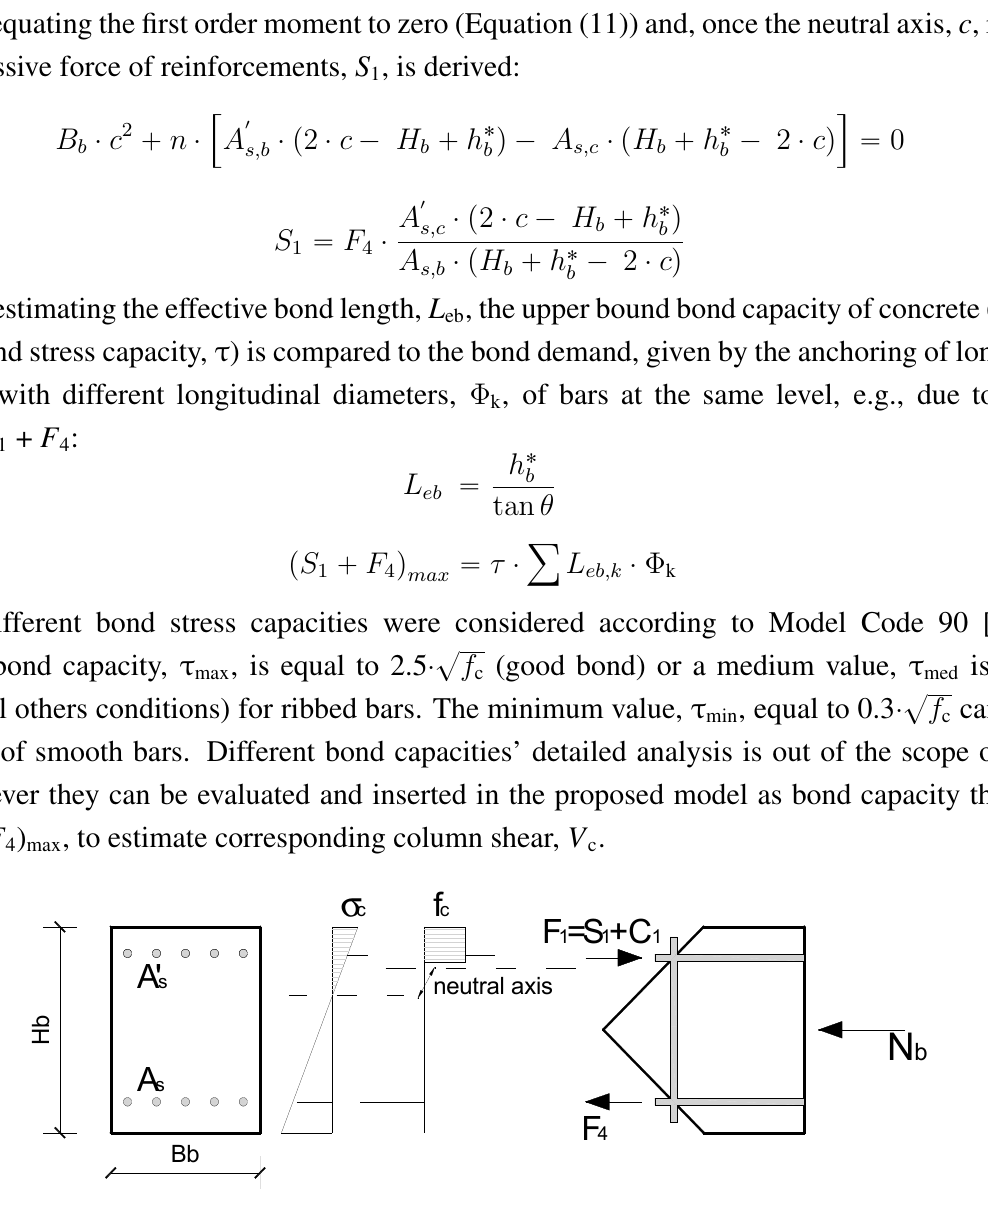
Figure 3. Analysis of distribution of compressive forces in concrete and reinforcement bars.